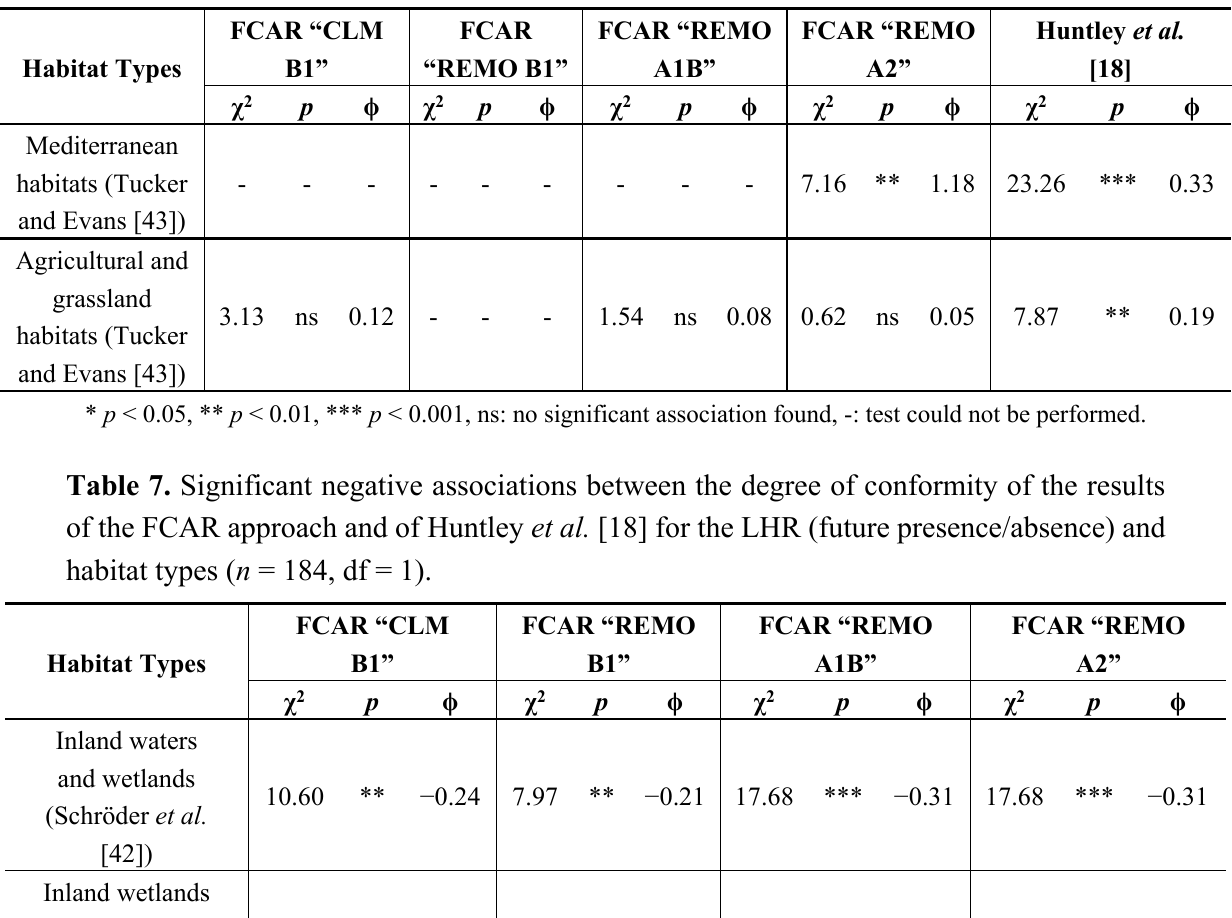
Table 6. Significant positive associations between species that are classified as “potential arrivers” and habitat types. All species are taken into account that are present in the LHR or FCARs today, or that are projected by Huntley et al. [18] to be present in the LHR in future ( n = 218, df = 1).